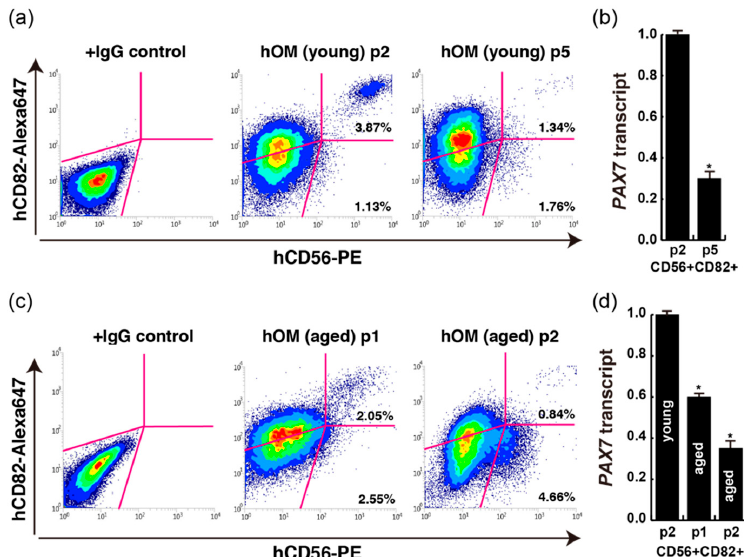
Figure 4. FACS analyses with each primary cultured human orbicularis oculi muscle (hOM). ( a ) FACS data of CD56 + CD82 + double positive cells from cultured double positive cells (passage 2, p2; passage 5, p5) from dissected extra eyelid tissue (14-year-old male patient; young). ( b ) PAX7 transcription of CD56 + CD82 + sorted cells from di ff erent passage times. n = 3 independent replicates; p -values were determined by t -test from a two-tailed distribution. * p < 0.01. ( c ) FACS data of CD56 + CD82 + double positive cells from cultured double positive cells (passage 1, p1; passage 2, p2) from dissected extra eyelid tissue (74-year-old male patient; aged). ( d ) PAX7 transcription of CD56 + CD82 + sorted cells from di ff erent age and passage samples. n = 3 independent replicates; p -values were determined by t -test from a two-tailed distribution. * p <